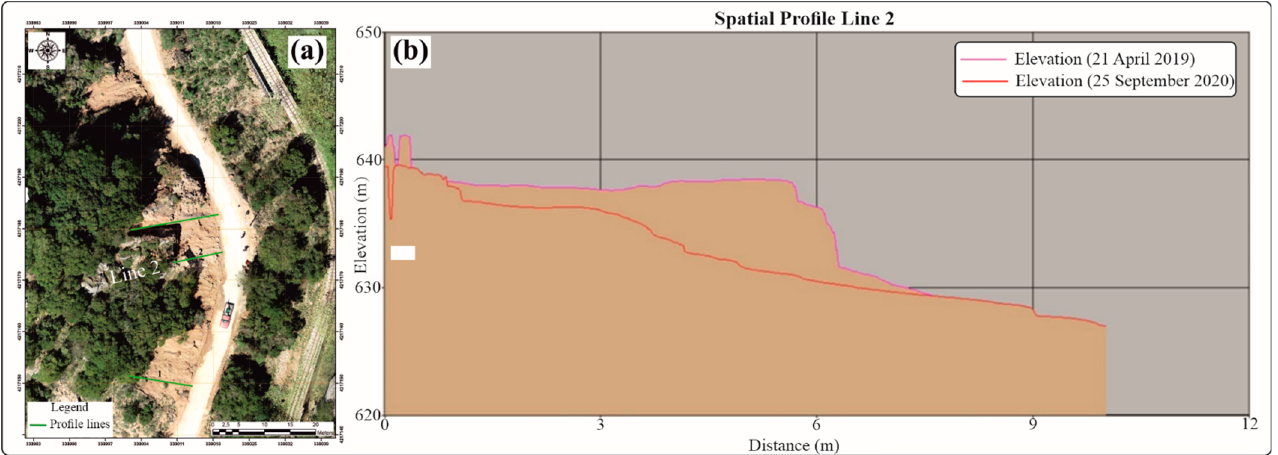
Figure 10. Surface profiles capturing relief modification after the stabilization operations. ( a ) Disribution of the profile sections within the area of interest. ( b ) Multitemporala surface profiles. The surface profile of April 2019 is shown in magenta, while the respective profile after the remediation of slope is depicted in red.